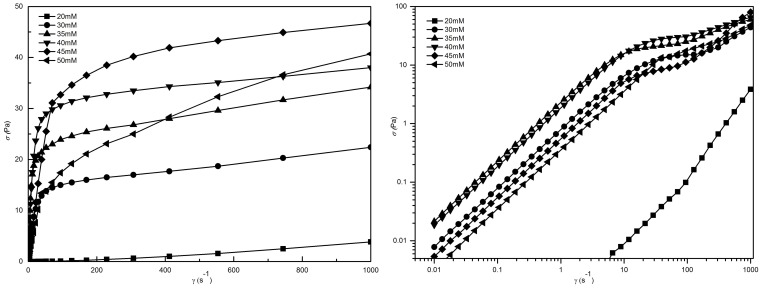
Shear stress with different concentration of SL at a fixed C16MDB concentration of 70 mM.